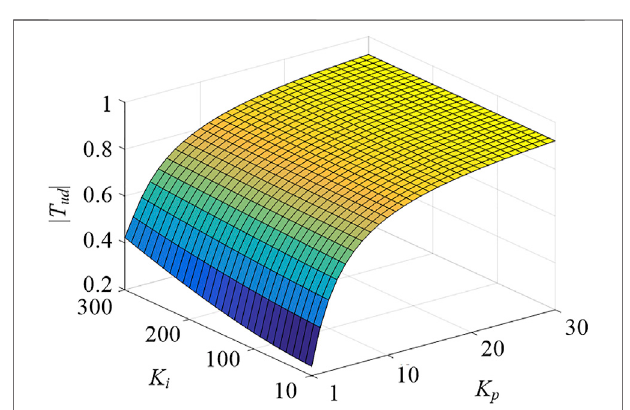
FIGURE 8 | | T ud | versus different K p and K i values.